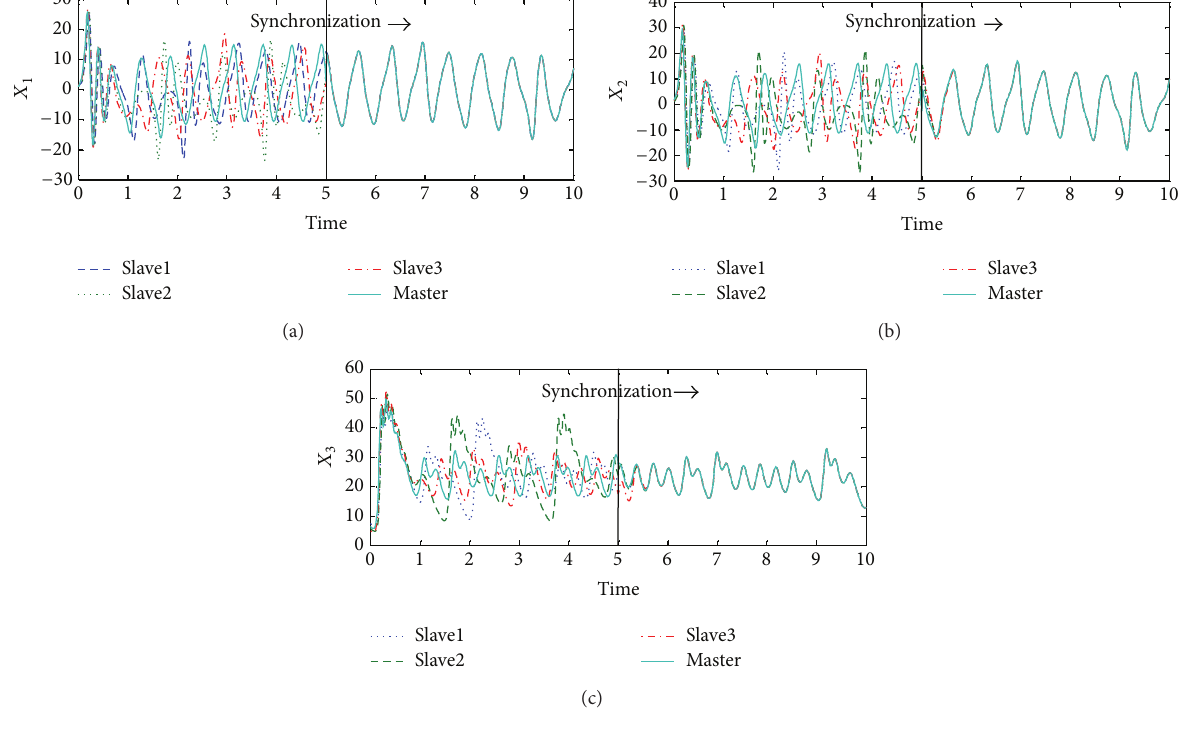
Figure 1: Trajectories of master and slaves systems in synchronization.